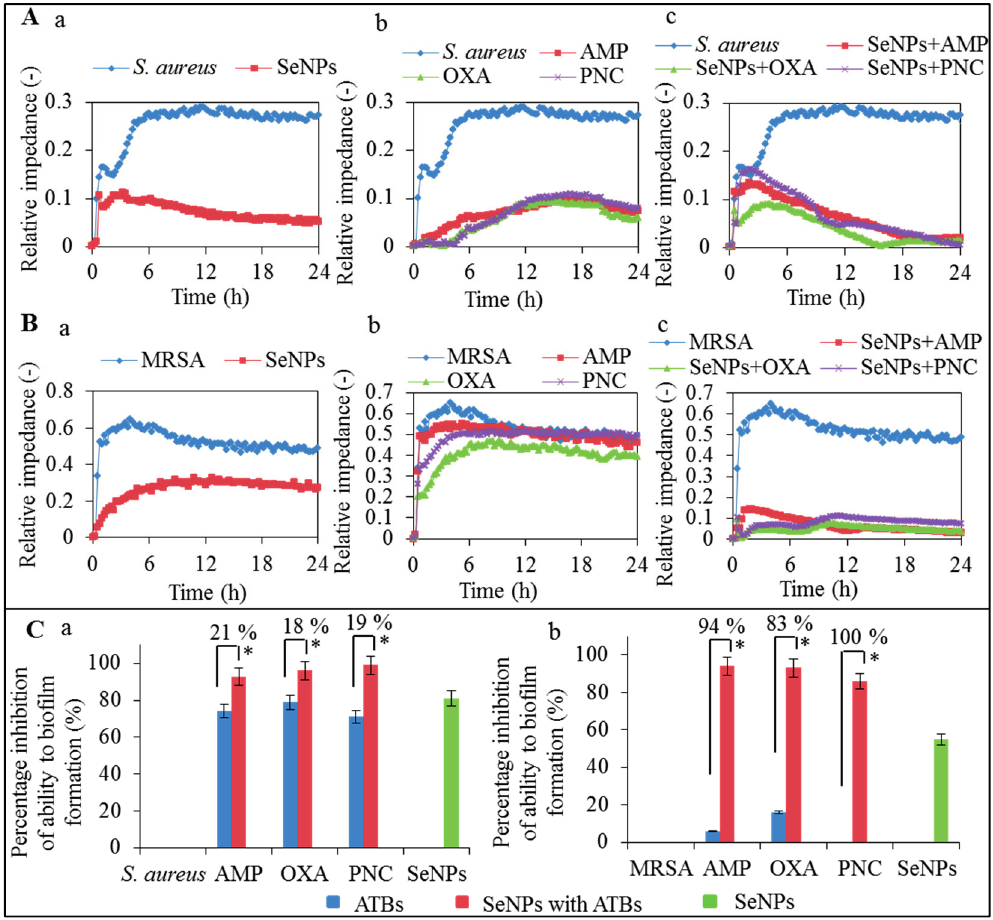
Figure 2. ( A ) Monitoring of biofilm disruption after application of 100 μ M SeNPs on S. aureus —blue line ( a ) and ATBs (100 μ M): ampicillin—red line, oxacillin—green line, penicillin—purple line on S. aureus —blue line ( b ) and complexes of SeNPs (100 μ M) with the same ATBs (100 μ M) on S. aureus —blue line ( c ); ( B ) Monitoring of biofilm disruption after application of 100 μ M SeNPs on MRSA—blue line ( a ) and ATBs (100 μ M) ampicillin—red line, oxacillin—green line, penicillin—purple line on MRSA—blue line ( b ) and complexes of SeNPs (100 μ M) with the same ATBs (100 μ M) on MRSA—blue line ( c ); ( C ) Comparison of differences in relative impedance after application of 100 μ M concentration of ATBs or complexes of ATBs with SeNPs (100 μ M) and SeNPs alone (100 μ M) on S. aureus ( a ) and MRSA ( b ) after 24 h of measurement. All data represent mean ± S.D. from three measurements, NS, not significant, * p <